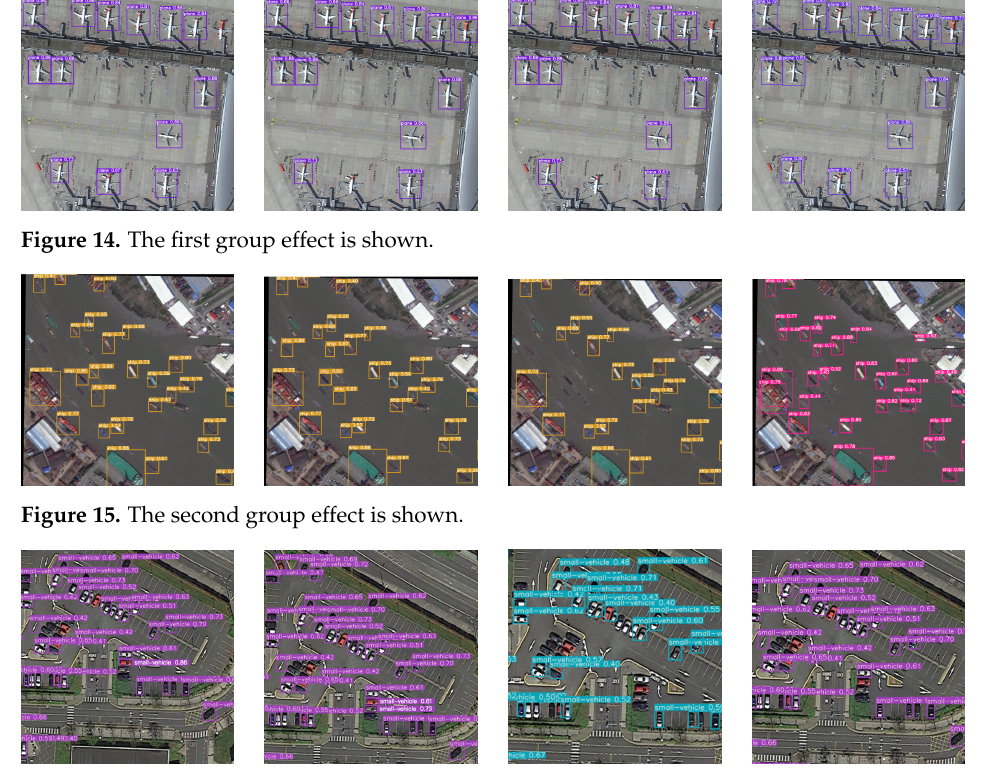
Figure 16. The third group effect is